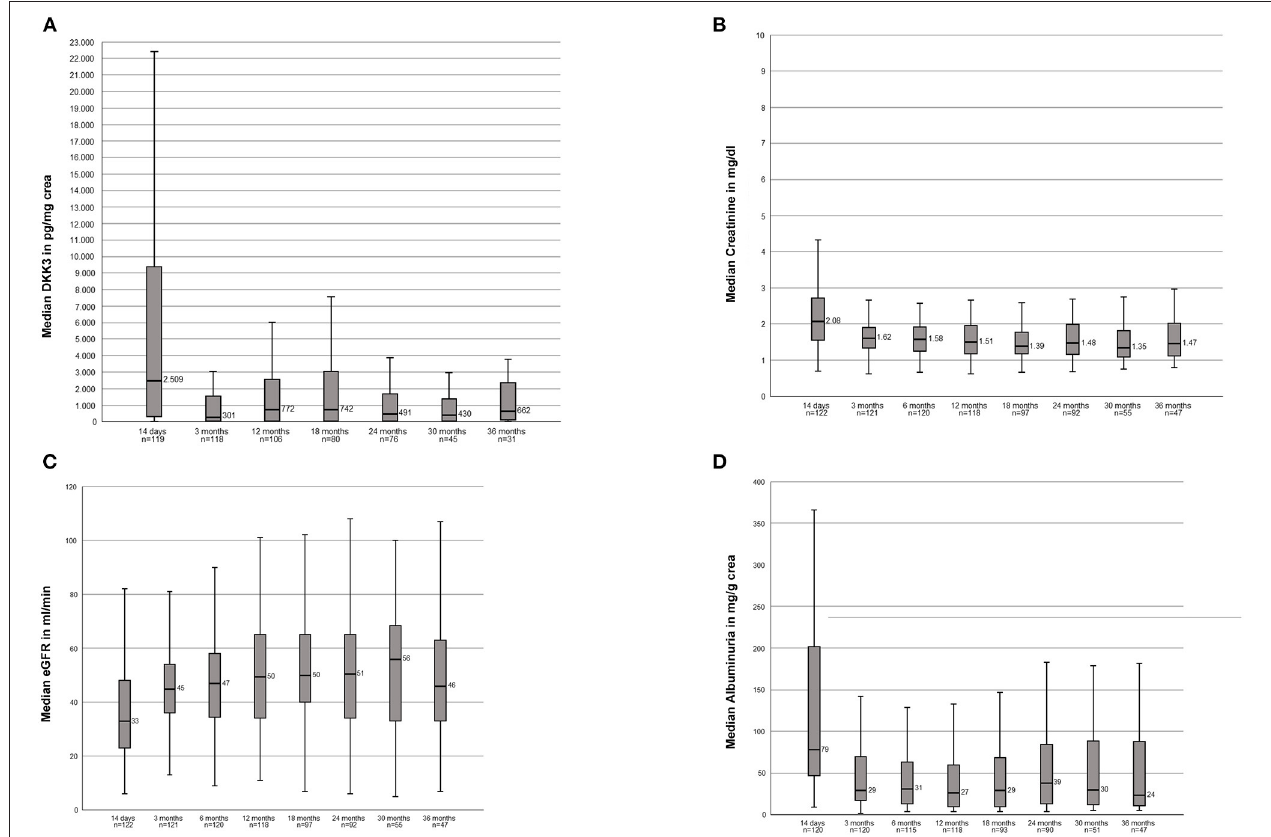
FIGURE 1 | (A) Course of the DKK3 values over the observation period of 3 years of the entire study population. (B) Course of the serum creatinine values over the observation period of 3 years of the entire study population. (C) Course of the eGFR over the observation period of 3 year of the entire study populations. (D) Course of the albuminuria over the observation period of 3 years of the entire study